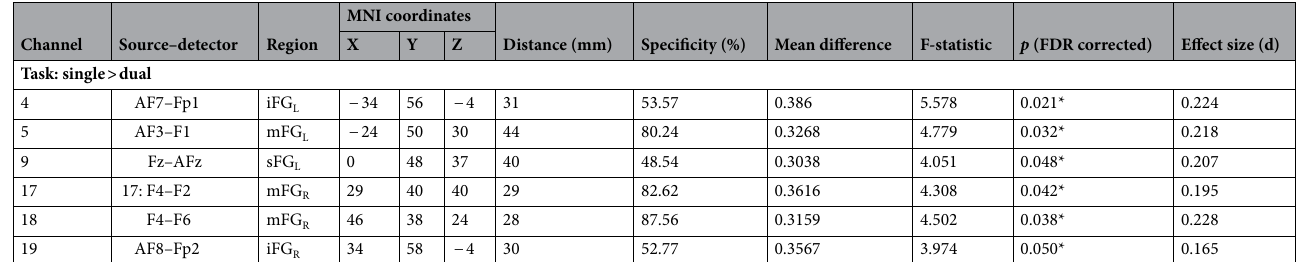
Table 3. Neural efficiency of physical performance (main effects). Significant Channels (at Source–Detector locations) using MNI coordinates (X, Y, and Z), with the region designation of main effects for Neural Efficiency of Physical Performance for Group, Task, and Interaction. Specificity/Coverage of the region per channel is detailed, with the mean difference for the comparison (not applicable in interaction between Group and Task), along with statistical information (F-statistic, p -value, and effect size [not applicable for Interaction between Group and Task]). ( p < 0.1 X , p < 0.05*, p < 0.01**, p <